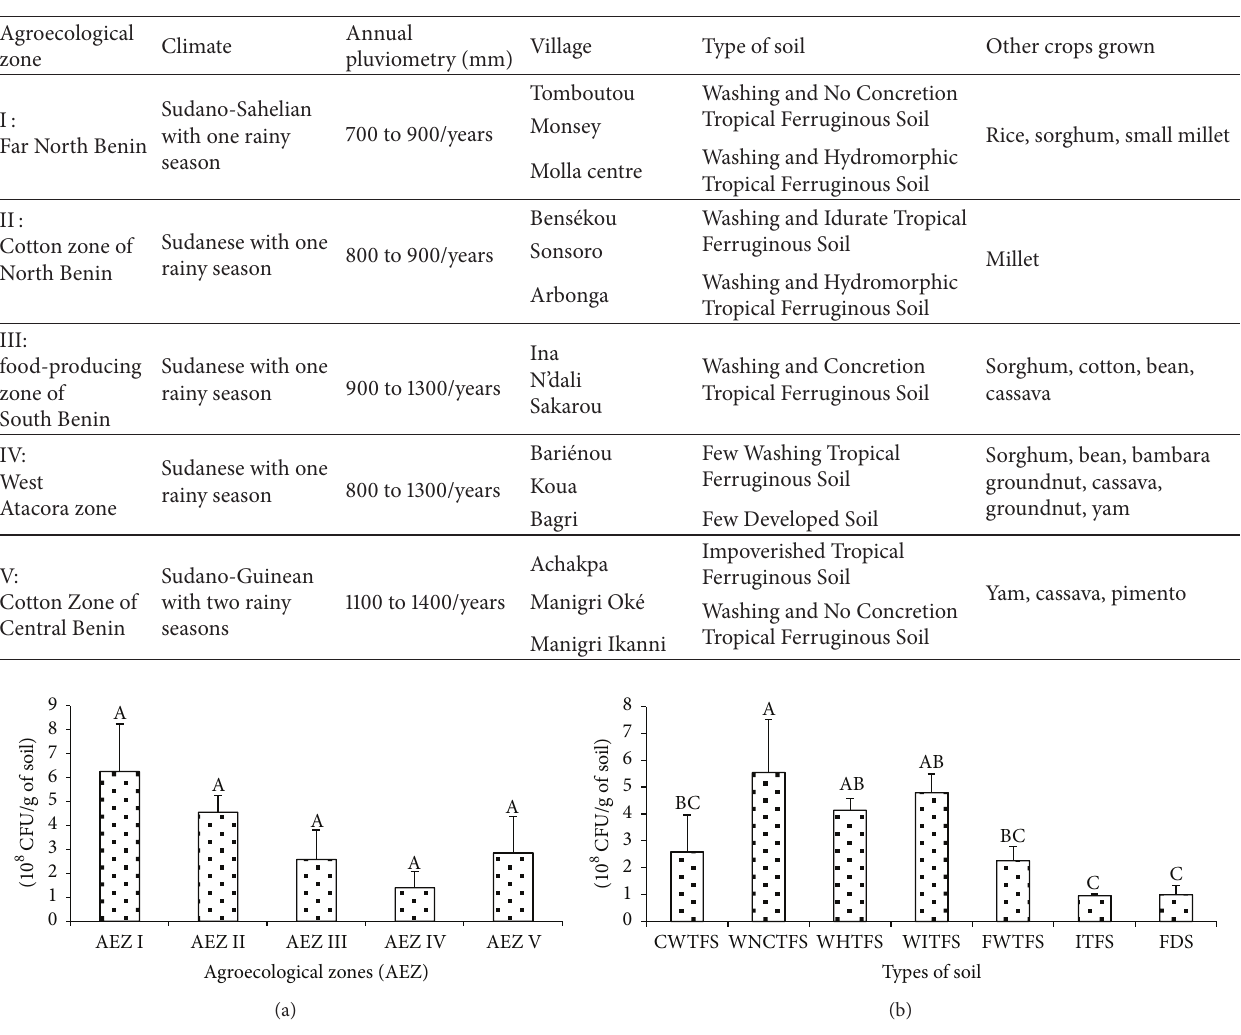
Table 1: Agroecological characteristics of villages surveyed.